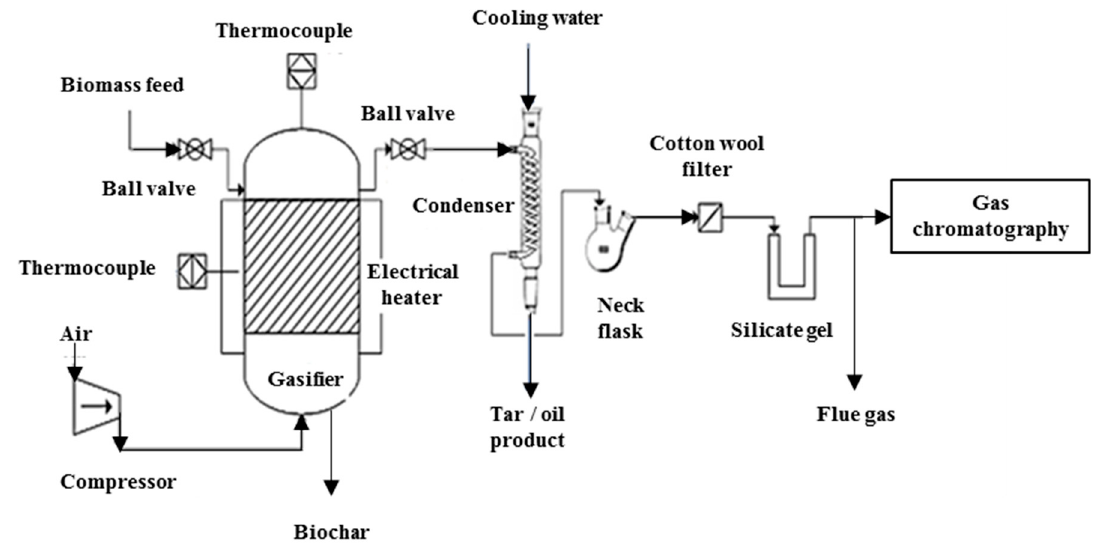
Figure 1. Process flow diagram of lab scale gasifier setup.